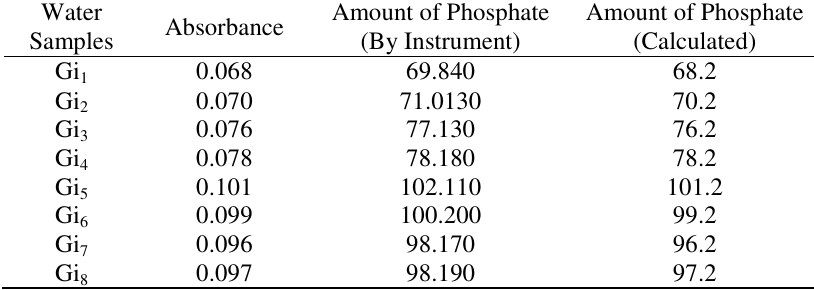
Table 5. Absorbance and concentration of phosphate (by Instrument and Calculation) of water samples of Girna